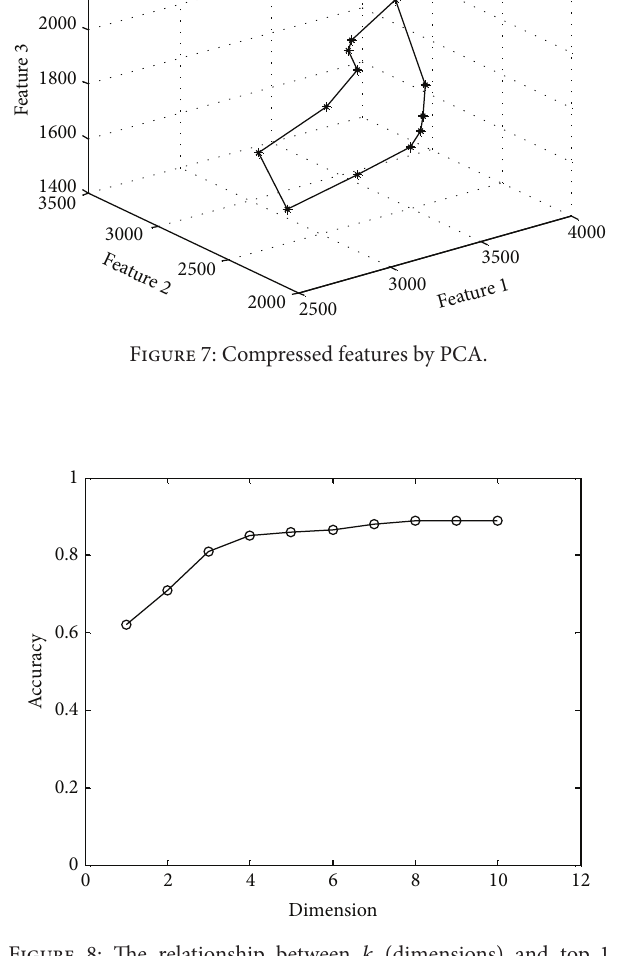
Figure 8: The relationship between 𝑘 (dimensions) and top 1 recognition accuracy.